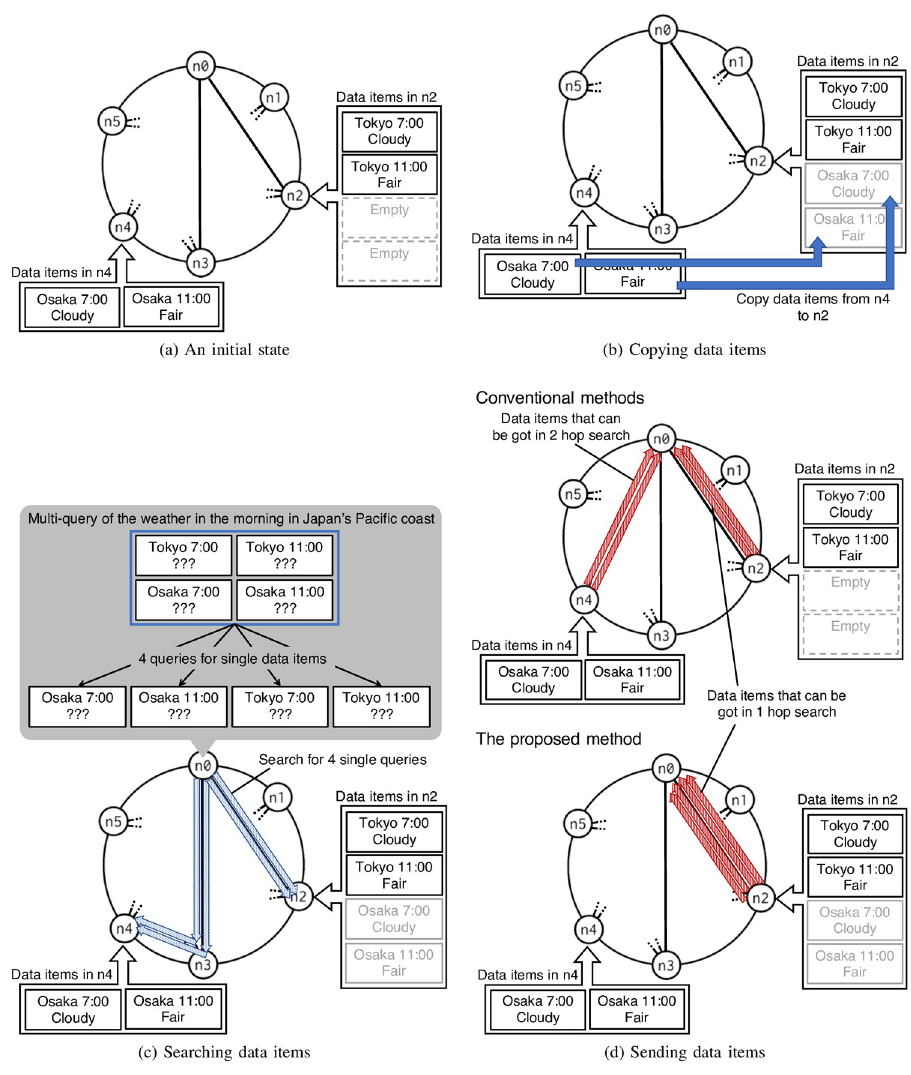
Fig 3. Steps of the proposed